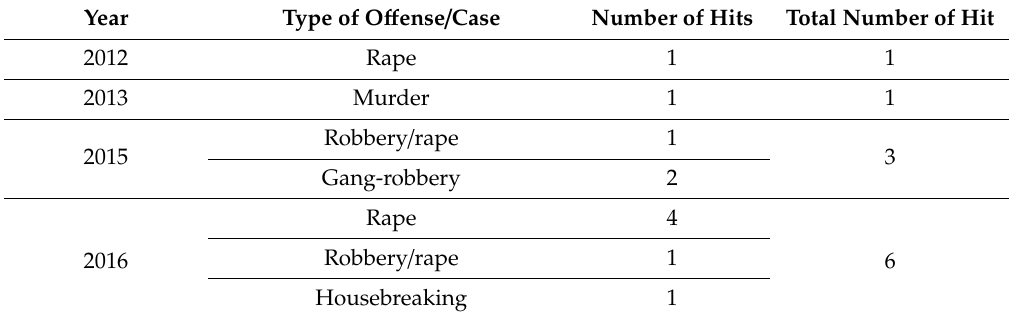
Table 2. List of hits from FDDM by